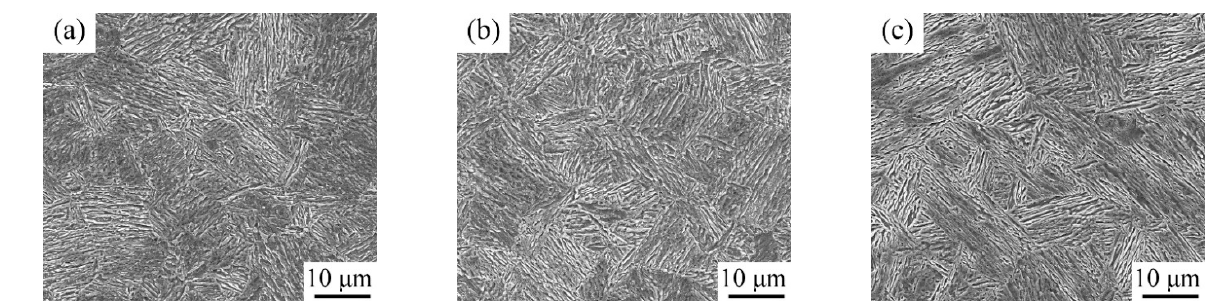
Figure 3. SEM images after being intercritically annealed at 650 °C: ( a ) 6 h; ( b ) 12 h; and ( c ) 50 h. The XRD spectra of the experimental steel depict the diffraction peaks of γ -Fe and α -Fe in Figure 4. In view of the high hardenability of the 0.2C-5Mn alloying steels, very little undercooled austenite remained even if the steel was subjected to air cooling [21]. Based on Equation (1), the measured contents of PRA were 28.63%, 31.56% and 28.63%, respectively. With an increase in IA time, the contents of PRA firstly increased and then decreased, indicating that the α / γ interface migrated into the martensite lath interior [14], and the martensite transformation occurred.